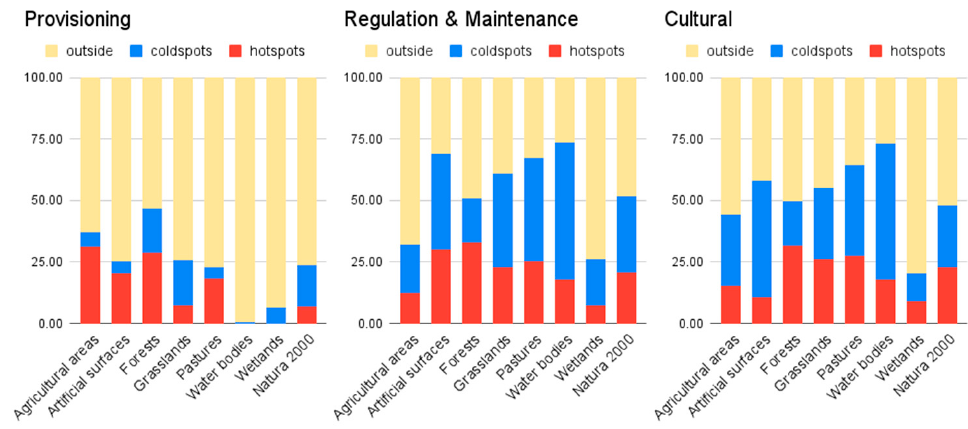
Figure 7. Distribution of land cover categories (including CLC and Natura 2000) and Natura 2000 network inside and outside of cold- and hotspots of ES.